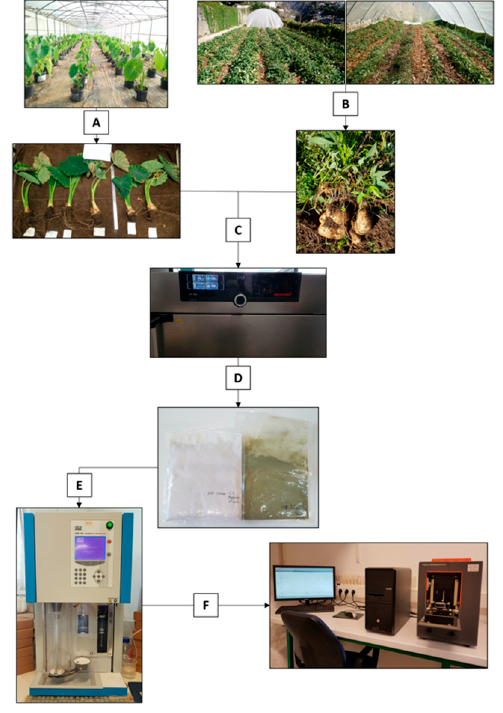
Figure 1. Taro and sweet potato crops were submitted to drought stress for two agronomic trials in distinct experimental sites, but they share the same steps from harvest until analysis. A—harvest of the plants of the taro drought assays performed in an open greenhouse in 2015 and 2017, B—harvest of the plants of the sweet potato drought trials implemented in a split ‐ plot field design in 2017 and 2018, C—oven ‐ drying the underground and aboveground plant organs at 65 °C for 48 h, D—milling the dried samples and placing them into vacuum ‐ sealed bags stored at − 35 °C, E—flours from the 1st drought assay were chemically evaluated for quality constituents, F—NIR prediction of the quality constituents of the sample flours obtained from the 2nd drought